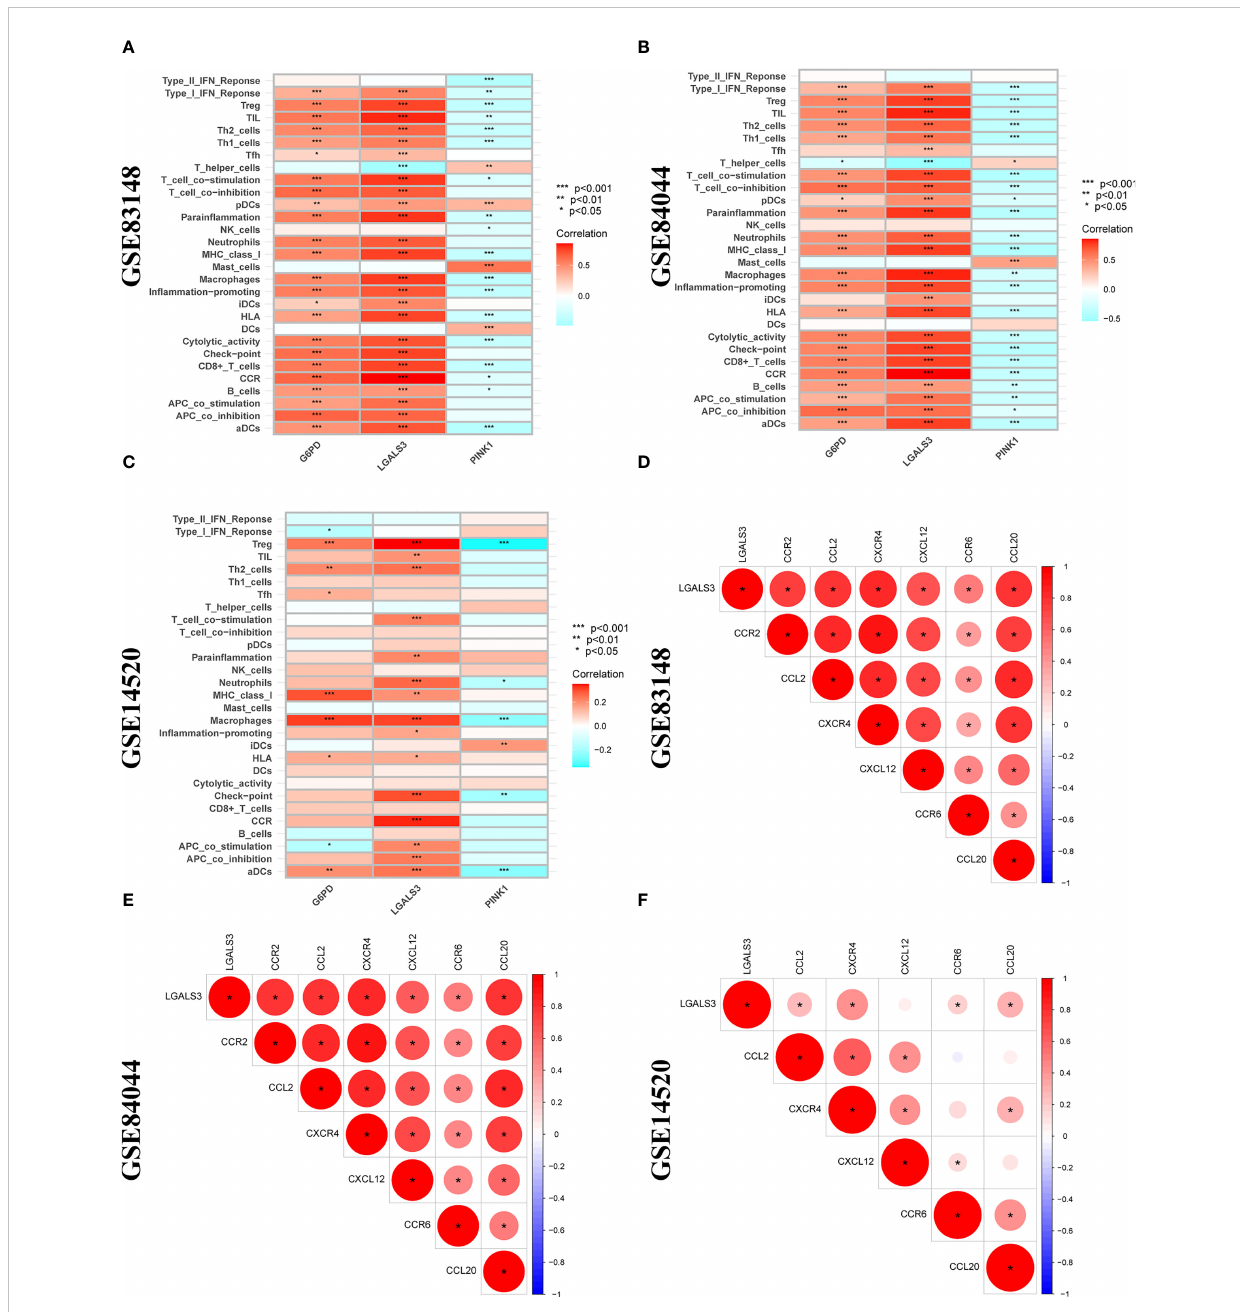
FIGURE 8 Correlation analysis between 3 DENRGs and immune microenvironment. The relationship between 3 DENRGs and immune microenvironment in (A) GSE83148, (B) GSE84044, (C) GSE14520. Correlation analysis of 3 DENRGs with chemokines and chemokine receptors in (D) GSE83148, (E) GSE84044, (F)